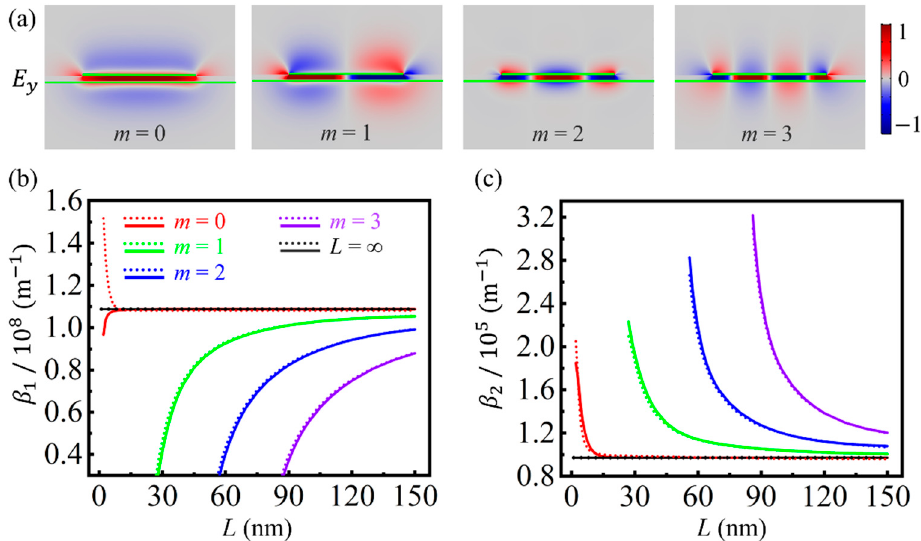
Figure 2. ( a ) Distributions of the y -components of electric fields, E y , for the four lowest-order GSPPs. The locations of graphene are indicated by the green lines. Dependences of the real ( b ) and imaginary ( c ) parts of β on L for the four modes. The solid and dashed lines correspond to the analytical model and simulation, respectively.